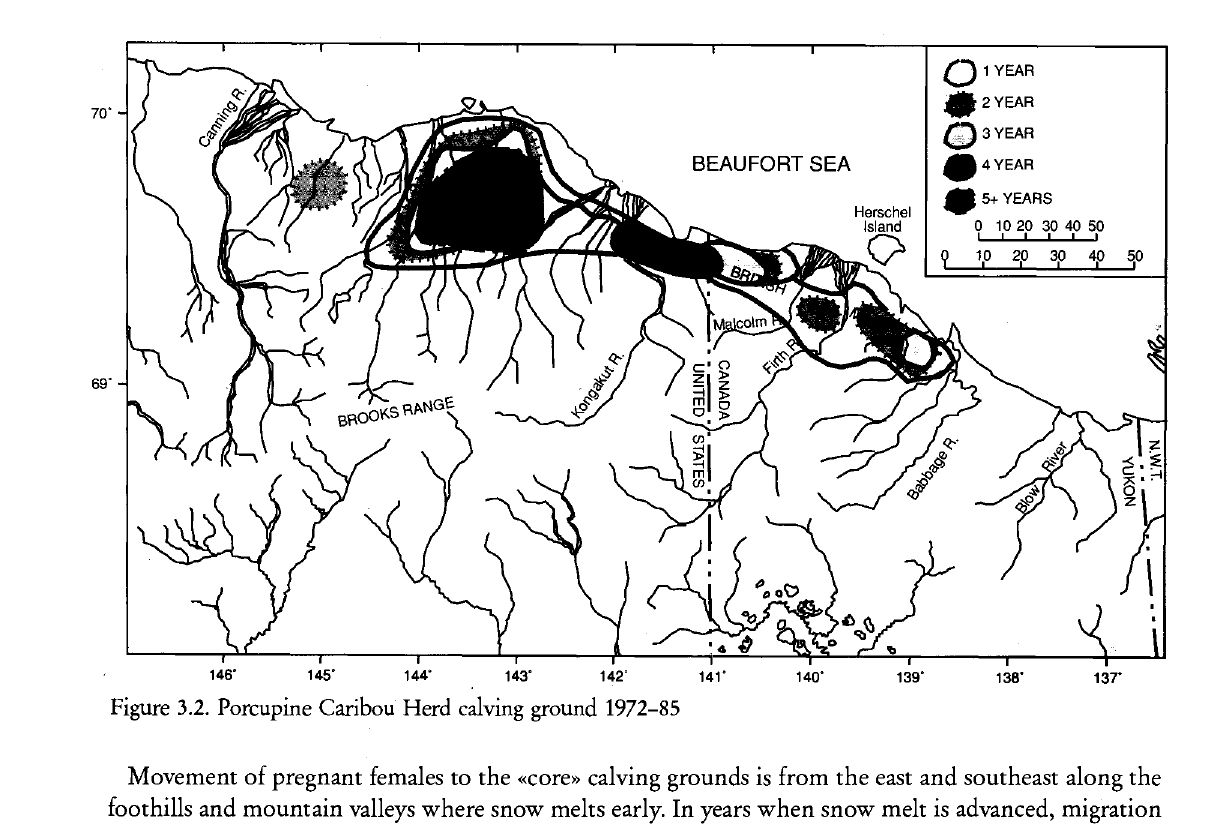
Figure 3.2. Porcupine Caribou Herd calving ground 1972-85 Movement of pregnant females to the «core» calving grounds is from the east and southeast along the foothills and mountain valleys where snow melts early. In years when snow melt is advanced, migration on to the calving grounds occurs along a more northerly, broad front across the foothills and coastal plain. Upon arrival within the core calving area, many caribou often move northward along corridors of early snow melt associated with major river